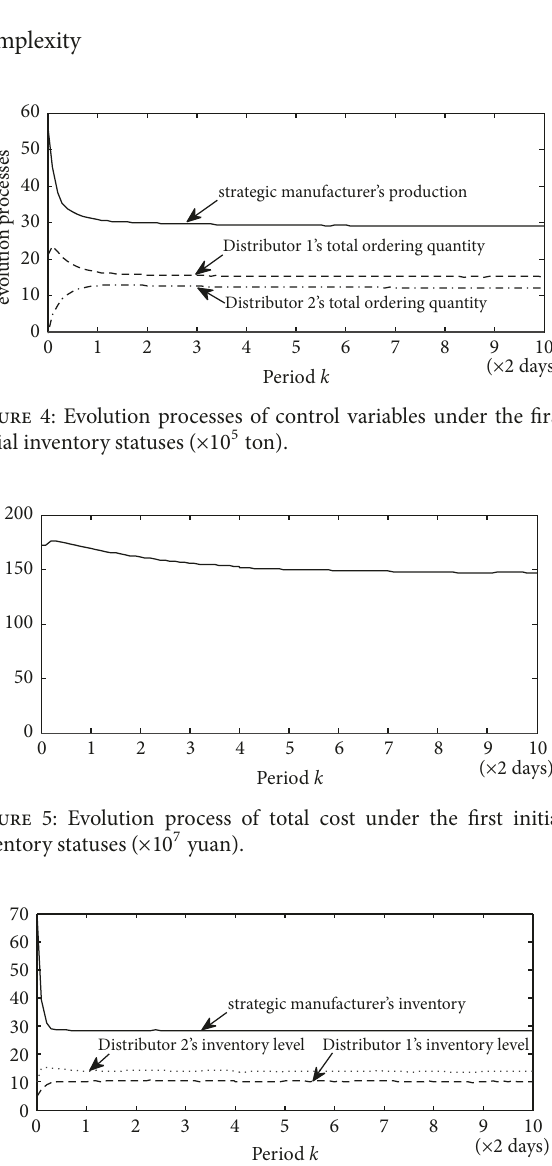
Figure 6: Evolution processes of state variables under the second initial inventory statuses ( ×10 5 ton).